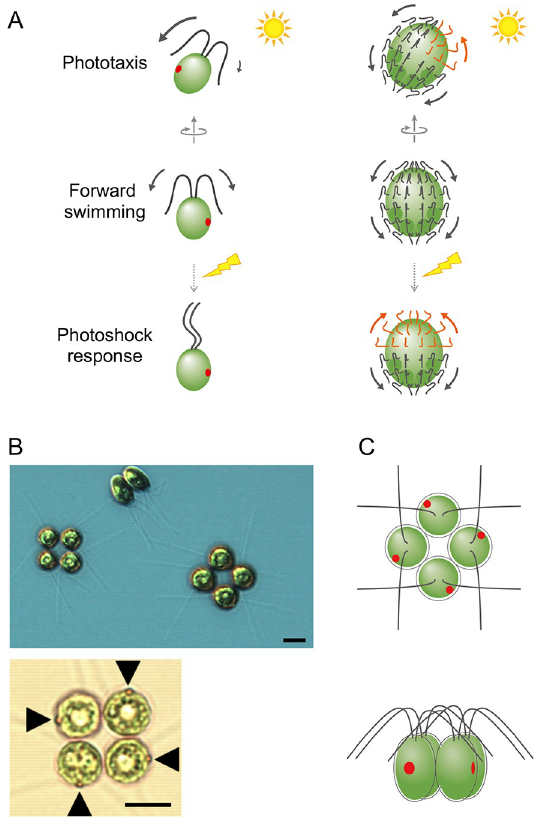
Fig 1. Tetrabaena socialis images and schematics of photobehavior in related volvocine species. (A) Schematics of photobehaviors in C . reinhardtii (left) and Volvox rousseletii (right). In C . reinhardtii , two cilia beat in opposite directions to propel the cell forward. For phototaxis, the force generated by two cilia becomes unbalanced, allowing the cell to change its swimming direction. For the photoshock response, the cilia waveform changes from asymmetrical to symmetrical, allowing the cell to swim backward. In V . rousseletii , all cilia beat toward the posterior pole of the spheroid for forward swimming. For phototaxis, the beating direction of cilia in the anterior hemisphere on the light- source side reverses. The force generated by cilia between the light-source hemisphere and the opposite hemisphere becomes imbalanced, changing the swimming direction of the spheroid. For the photoshock response, the beating direction of almost all cilia in the anterior hemisphere reverses. The forces generated by the anterior hemisphere and posterior hemisphere are balanced, stopping the spheroid motion. (B) A differential-interference-contrast (top) and a bright-field (bottom) images and (C) schematics of T . socialis NIES-571 colonies. Four cells are arranged in a square. Each T . socialis cell resembles a C . reinhardtii cell , possessing two cilia and one eyespot (arrowheads in the bottom panel). Scale bars: 10 μ